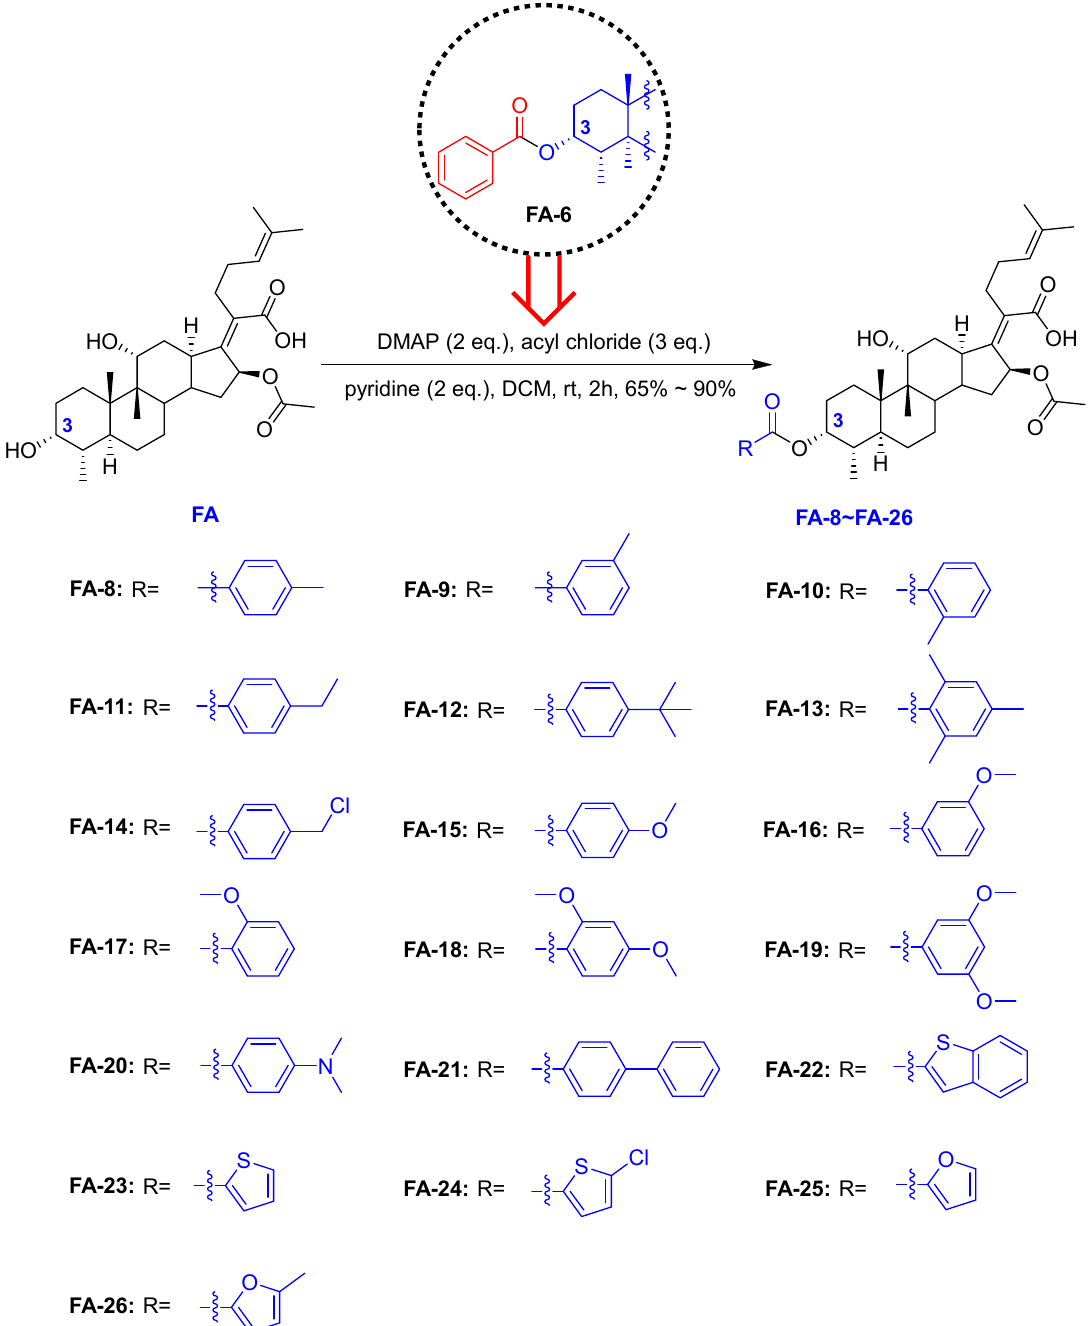
Scheme 2. The synthesis of fusidic acid ester derivatives 8–26 at the position of C-3. Reagents and conditions: DCM, DMAP, pyridine, acid chloride, r.t., and 3 h.